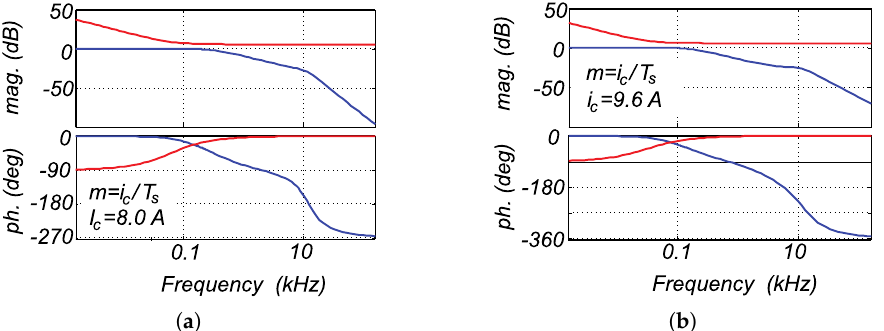
Figure 18. Frequency response, voltage control, closed loop (blue curve) and C v ( s ) (red curve), for ( a ) buck and; ( b ) boost controller design.